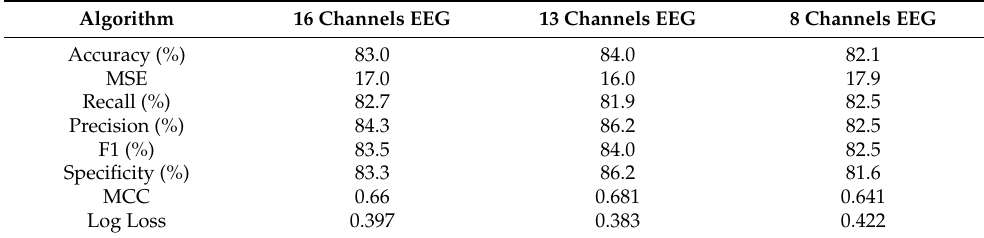
Table 10. The obtained performance metrics results using 16 channels, the first 13 channels, and the first eight channels EEG signals with the LGBM